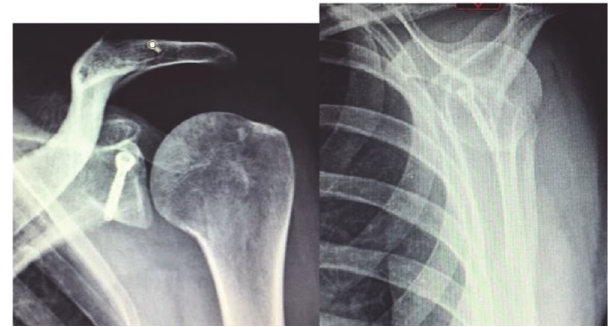
Figure 4: AP and lateral X-ray at 6-month